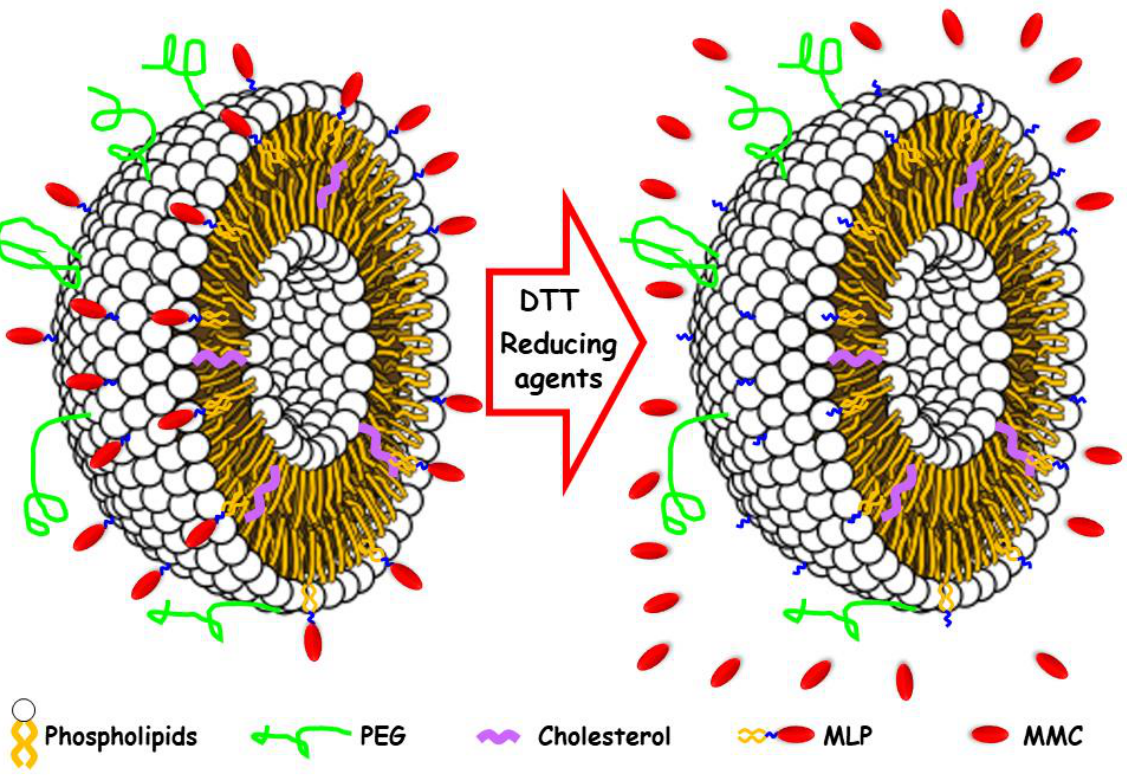
Figure 1. Schematic representation of the Promitil ® formulation, a pegylated liposome loaded with the prodrug MLP ( left ); in the presence of reducing agents present in tumor tissues, MMC is released thanks to the cleavage of the disulfide groups ( right ).